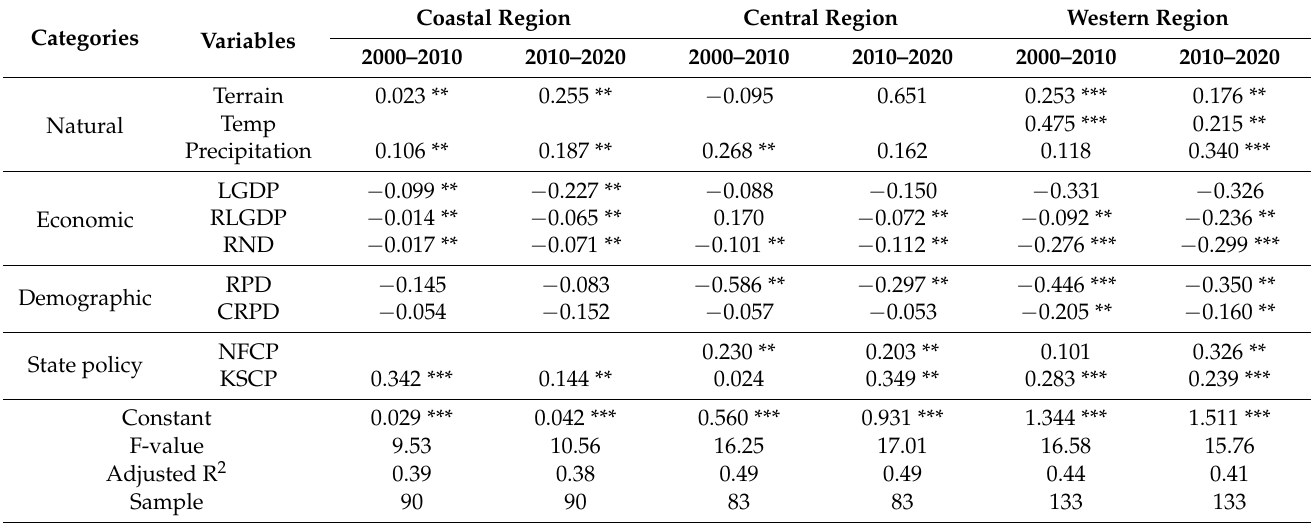
Table 5. The regression results for different